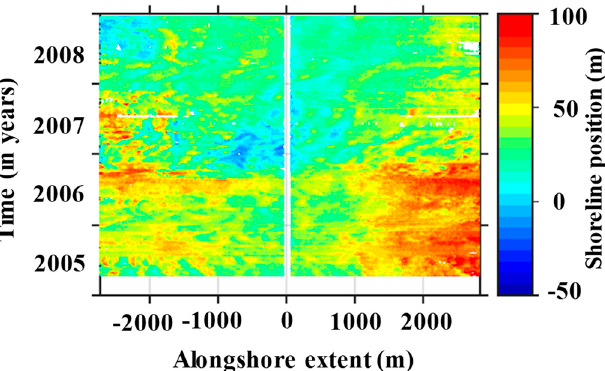
Figure 22. Spatial and temporal variations in the shoreline position derived by mTWM with corrected wave run-up during 12 April 2005 to 31 December 2008.